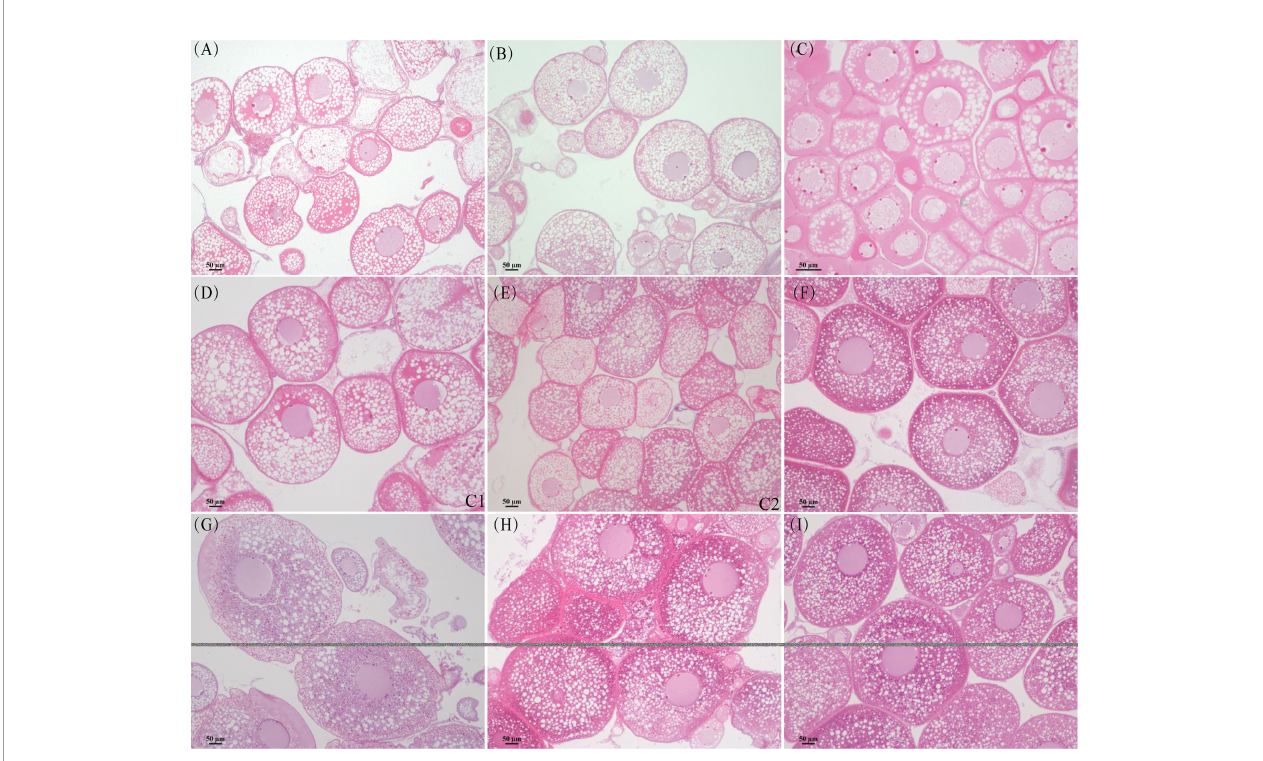
FIGURE 2 | Histology section of ovary in different groups. (A) Control group. (B) Group A1 (30 days). (C) Group A1 (60 days). (D) Group A2 (30 days). (E) Group A2 (30 days). (F) Group B1 (30 days). (G) Group B1 (60 days). (H) Group B2 (30 days). (I) Group B2 (60 days).